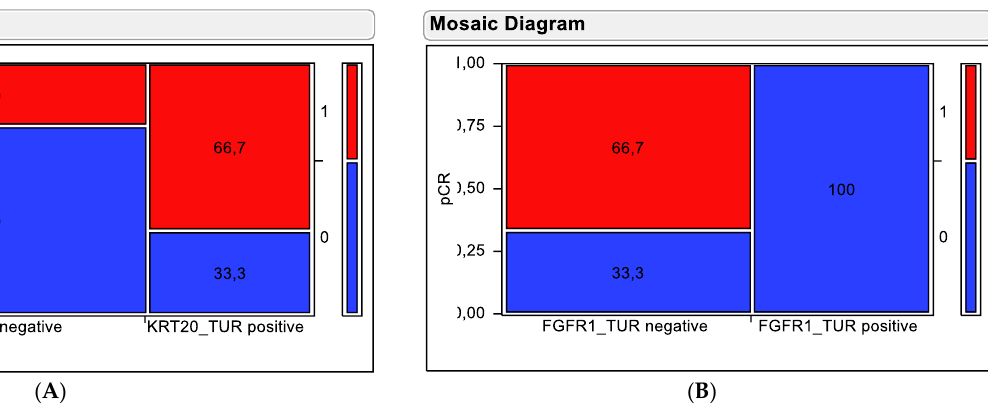
Figure 5. Contingency testing using ( A ) KRT20 mRNA and ( B ) FGFR1 mRNA in pre-therapy TUR biopsy samples for distinguishing responding from non-responding tumors. Tumors achieving pCR are depicted by red fields and resistant tumors are depicted by blue fields. Percentages of tumors in the stratification groups (high versus low expressors) are shown in the fields. The numbers on the left y-axis indicate the proportion in relation to all tumors, while the numbers on the right y-axis indicate the pCR categorization of the coloring with (1 = pCR achieved; 0 = no pCR).